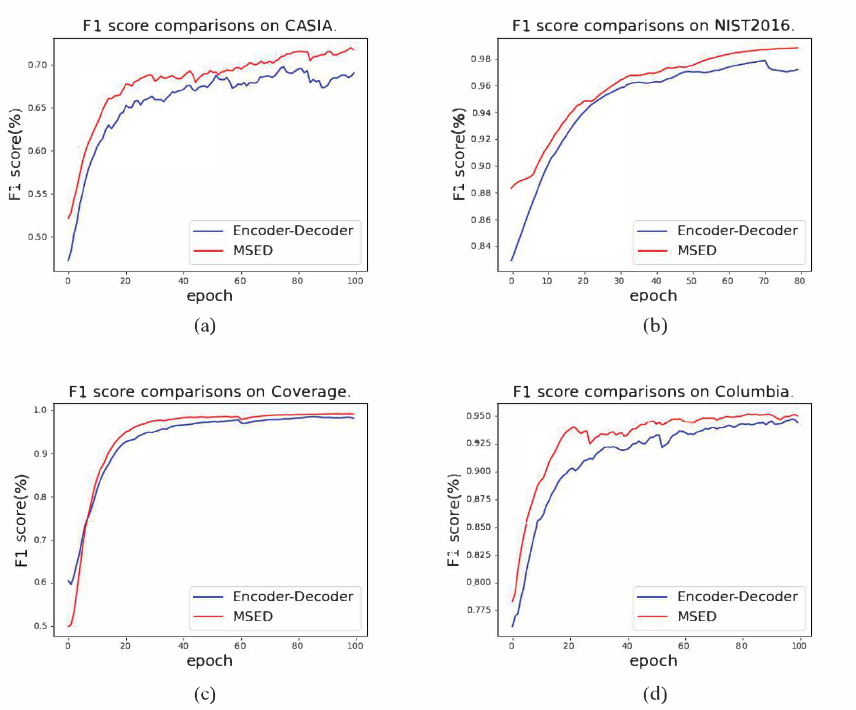
Figure 7. F 1 score (%) comparisons of MSED variants evaluated on CASIA ( a ), NIST2016 ( b ), Coverage ( c ), and Columbia ( d ). In each sub-graph, the blue curve represents the results of the basic encoder–decoder network, while the red curve means the results of the our proposed MSED model with additional multi-supervised module.